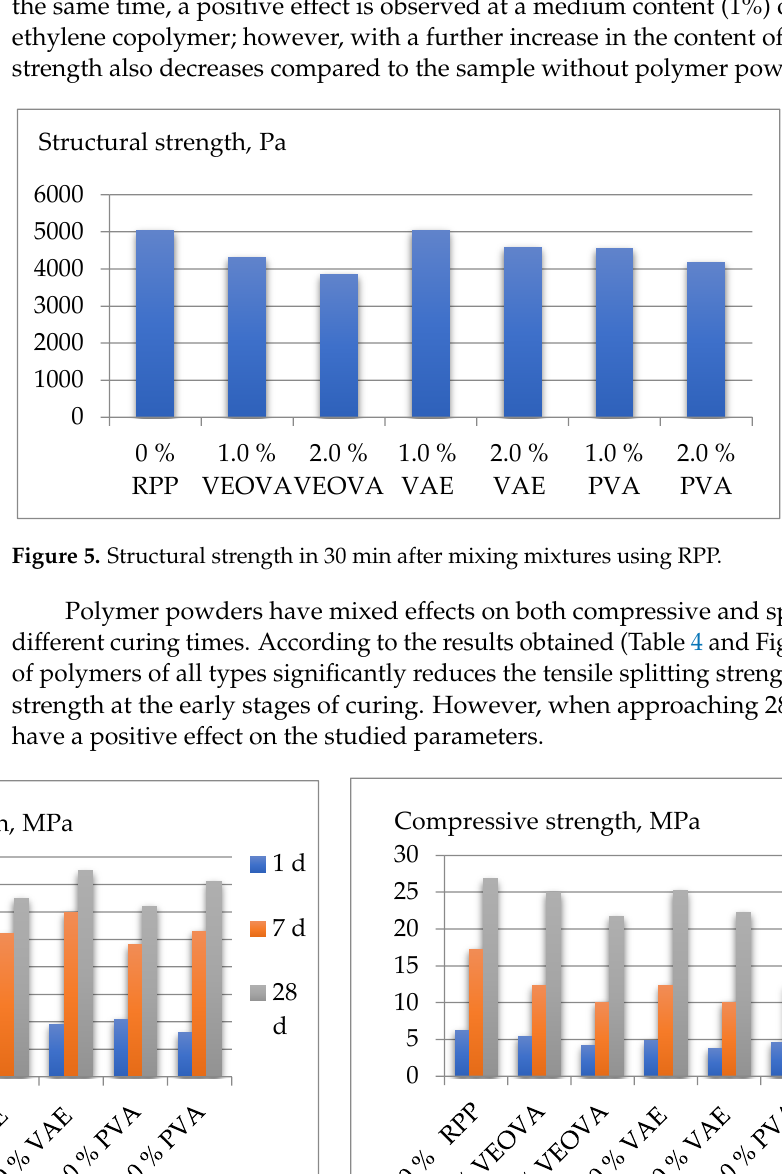
Figure 4. Properties of mixtures using RPP: ( a ) workability; ( b ) setting time.